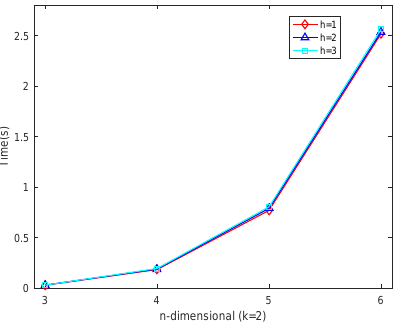
Figure 10. The average execution cost of the t/h-Diag